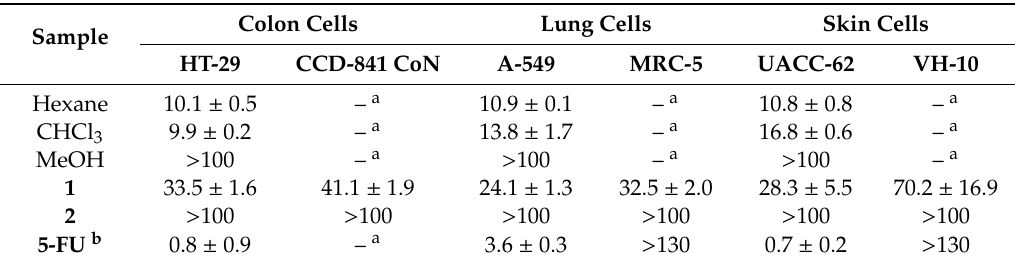
Table 2. Cytotoxic activity (IC 50 ) of extracts and phyllocladanes 1 and 2 against several human cell lines. Compounds were tested from 0.1 to 100.0 µ g mL − 1 .